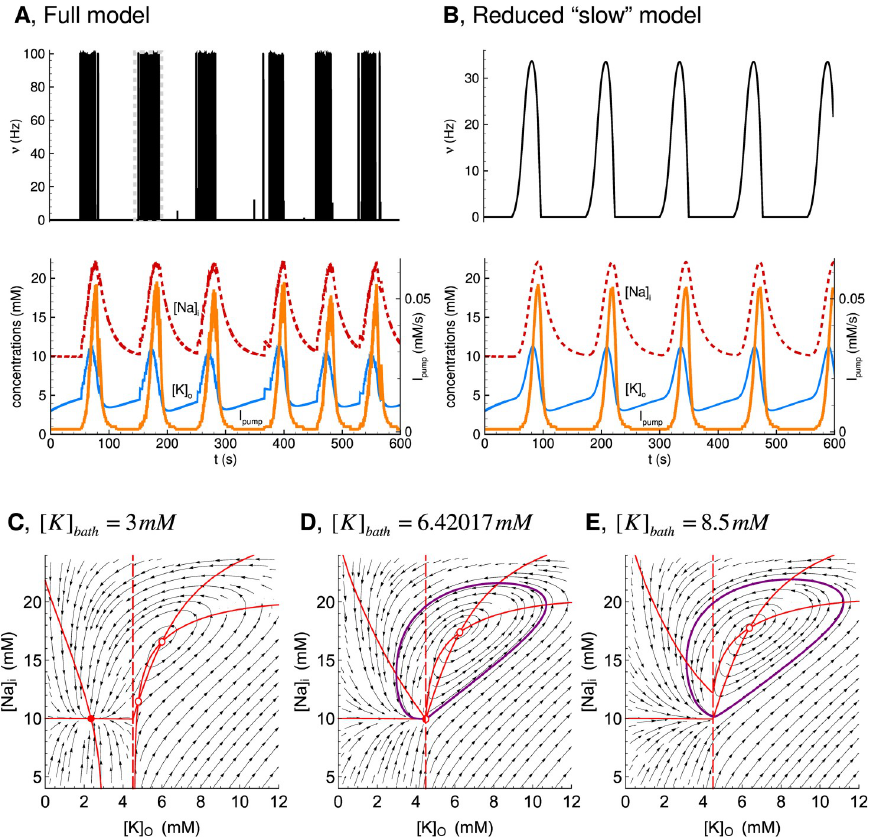
Fig 10. Slow subsystem producing IDs. (A) IDs in the full Epileptor-2 model. (B) Oscillations in the reduced model based on Eqs 1’, 2’, 5” and 8’. The plots repeat those in Fig 4. (C, D, and E) Phase portraits of the reduced model obtained for [K]bath = 3, 6.42017, and 8.5 mM, correspondingly. Note the stable node in C and the limit cycle around the unsteady focus in